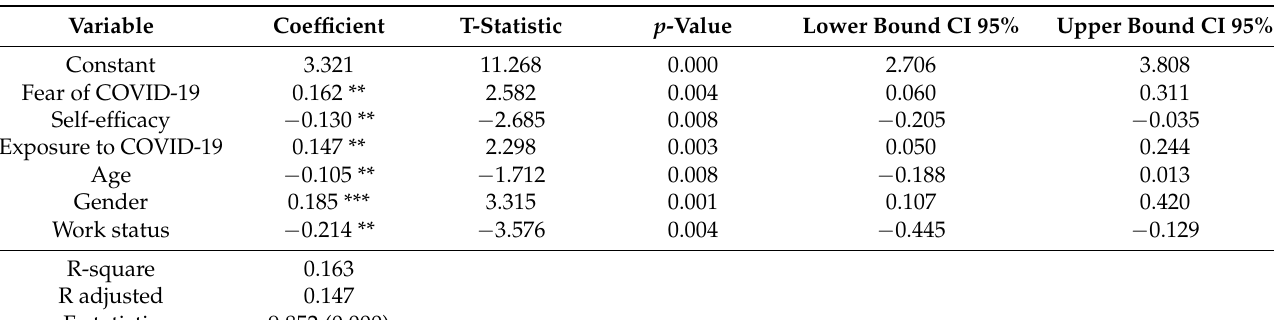
Table 3. Multiple